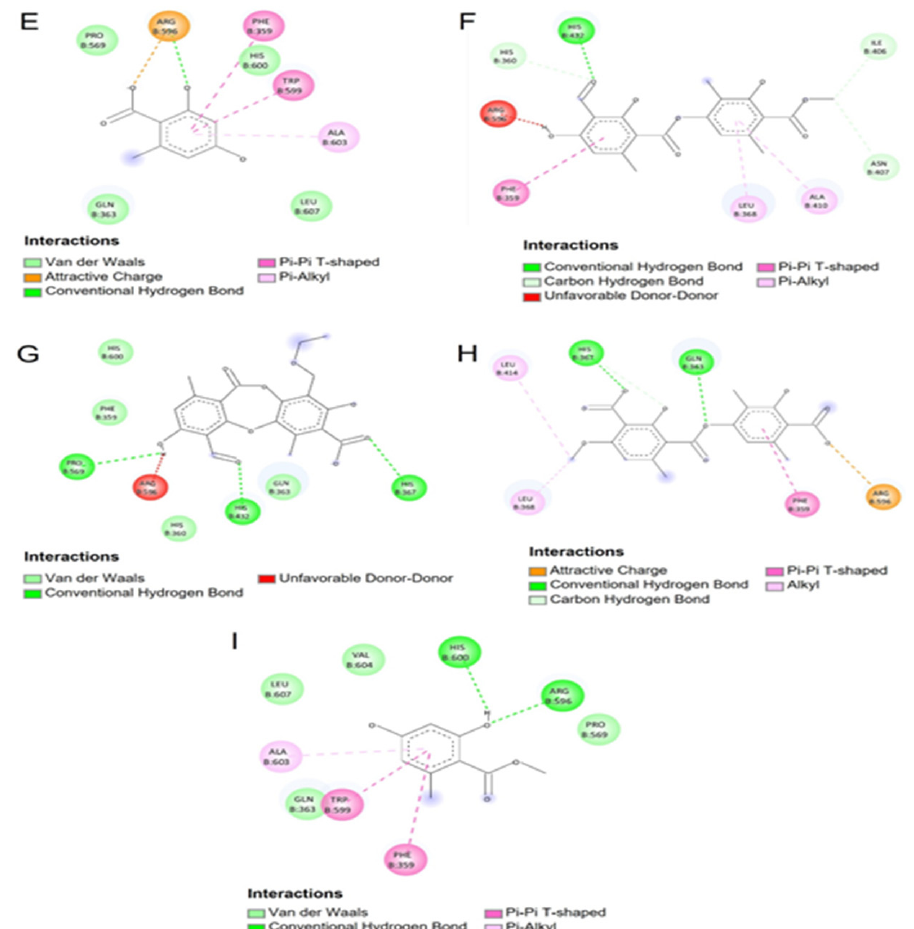
Figure 7. Molecular interactions of compounds present in the species of Cladonia . ( E ) Molecular interactions of orsellinic acid with the catalytic pocket of 5-LOX; ( F ) Molecular interactions of atranorin with the 5-LOX catalytic pocket; ( G ) Molecular interactions of cetraric acid with the catalytic pocket of 5-LOX; ( H ) Molecular interactions of squamatic acid with the 5-LOX catalytic pocket; ( I ) Molecular interactions of methylorsellinate with the 5-LOX catalytic pocket.